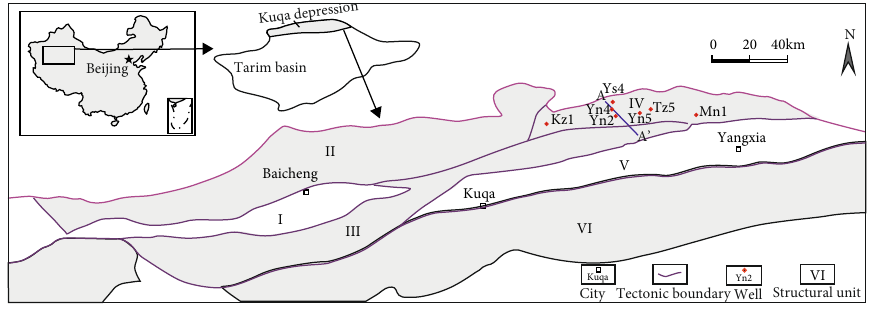
Figure 1: Regional, geological, and structural map of Dibei area in Kuqa Depression, Tarim Basin, Northwestern China (modi fi ed from [34 – 36]).